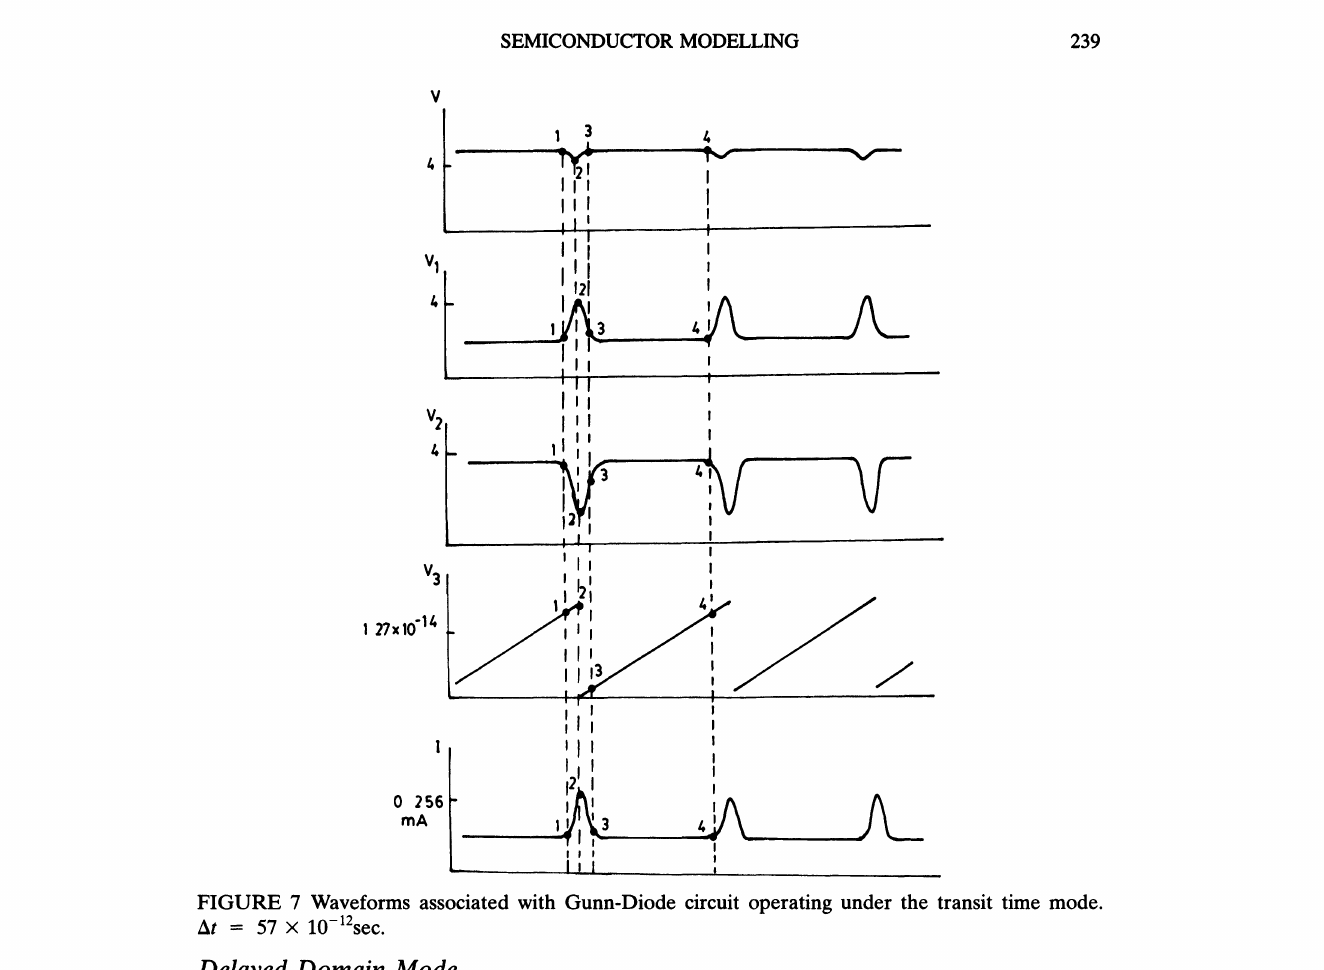
FIGURE 7 Waveforms associated with Gunn-Diode circuit operating under the transit time mode. At 57